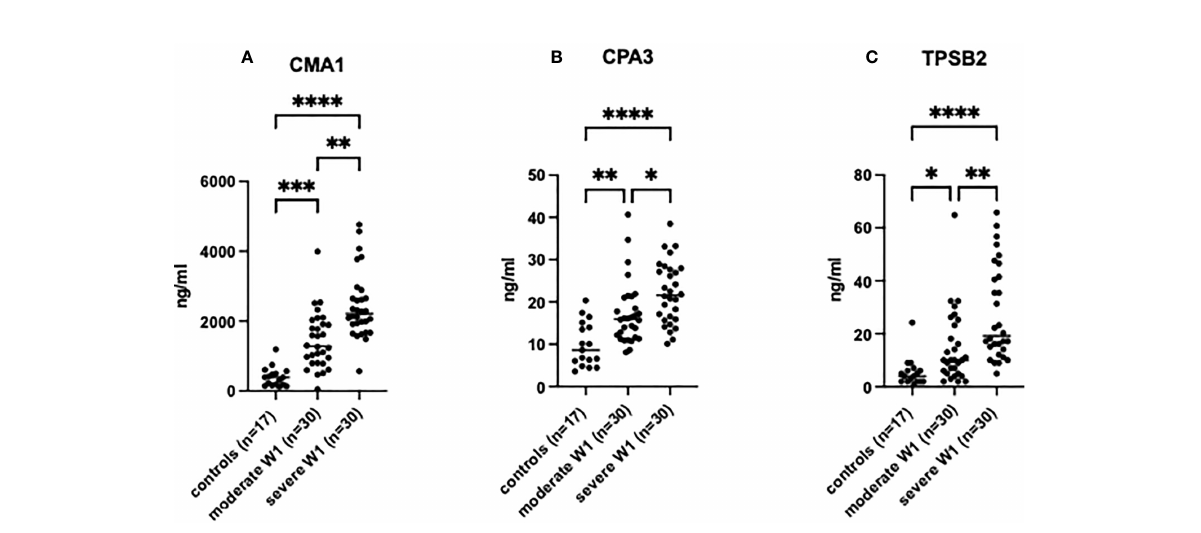
FIGURE 1 MC degranulation markers in patient serum are increased relative to clinical severity of patients post-SARS-CoV-2 infection. The presence of (A) CMA1, (B) CPA3 and (C) TPSB2 in patient serum was determined by ELISA. Healthy controls (n=17) were used to compare to patients post-